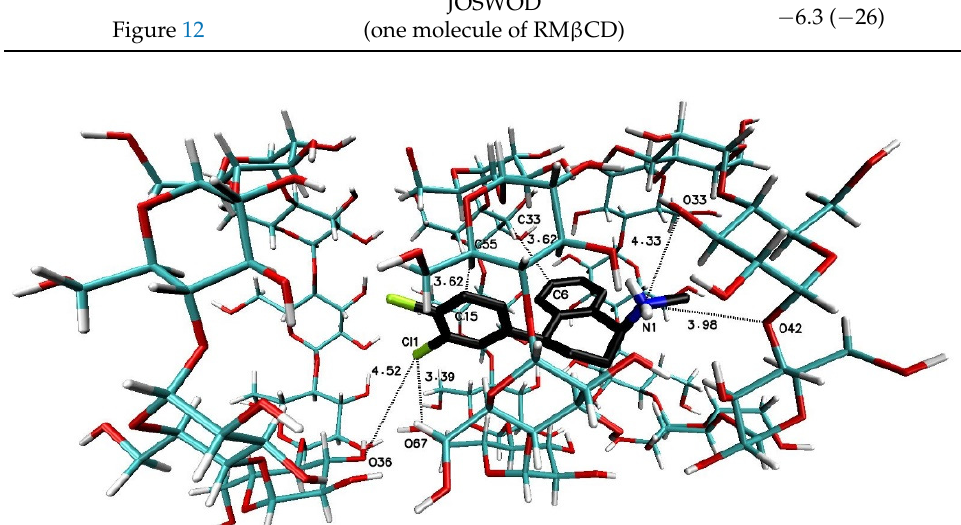
Figure 7. The geometry of the SRT- β CD complex with stoichiometry 1:3 (I-II-III or “head-to-head-to-tail” as in [69,70]) obtained by the Molecular Docking (MD) simulations with the use of β CD crystal structure with refcode 648855 [67] from The Cambridge Structural Database (CSD) [47].